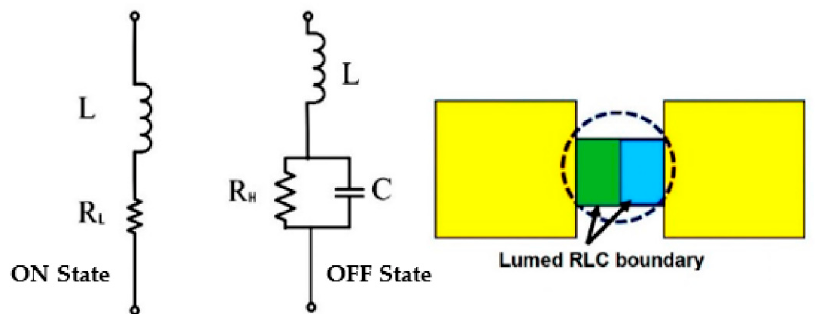
Figure 5. The equivalent circuits of the PIN diode and its CST